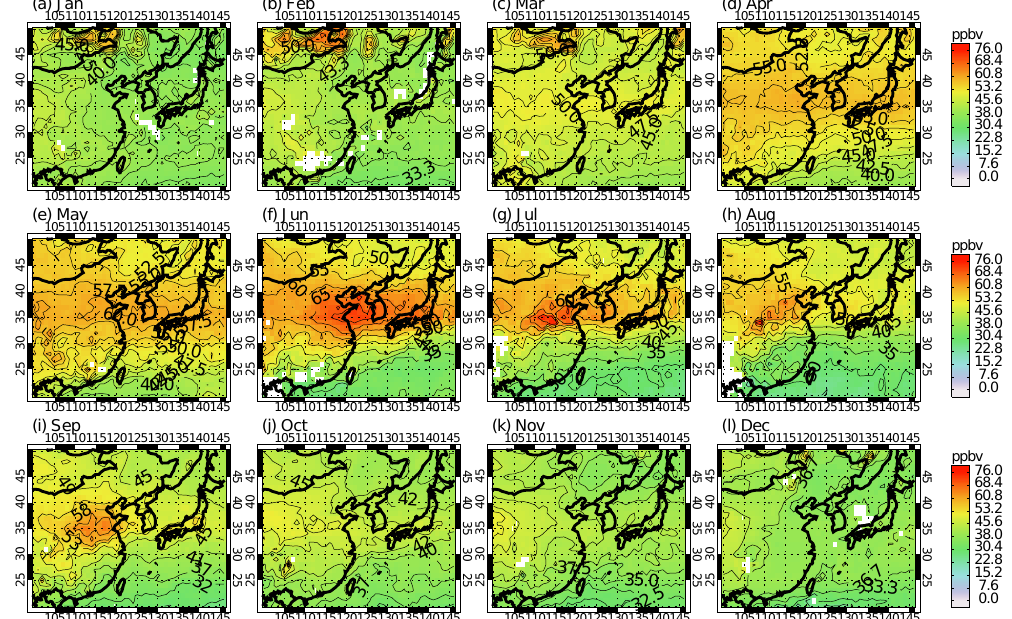
Figure 9. Maps of monthly mean values of retrieved ozone at the 24th layer from January to December 2005.